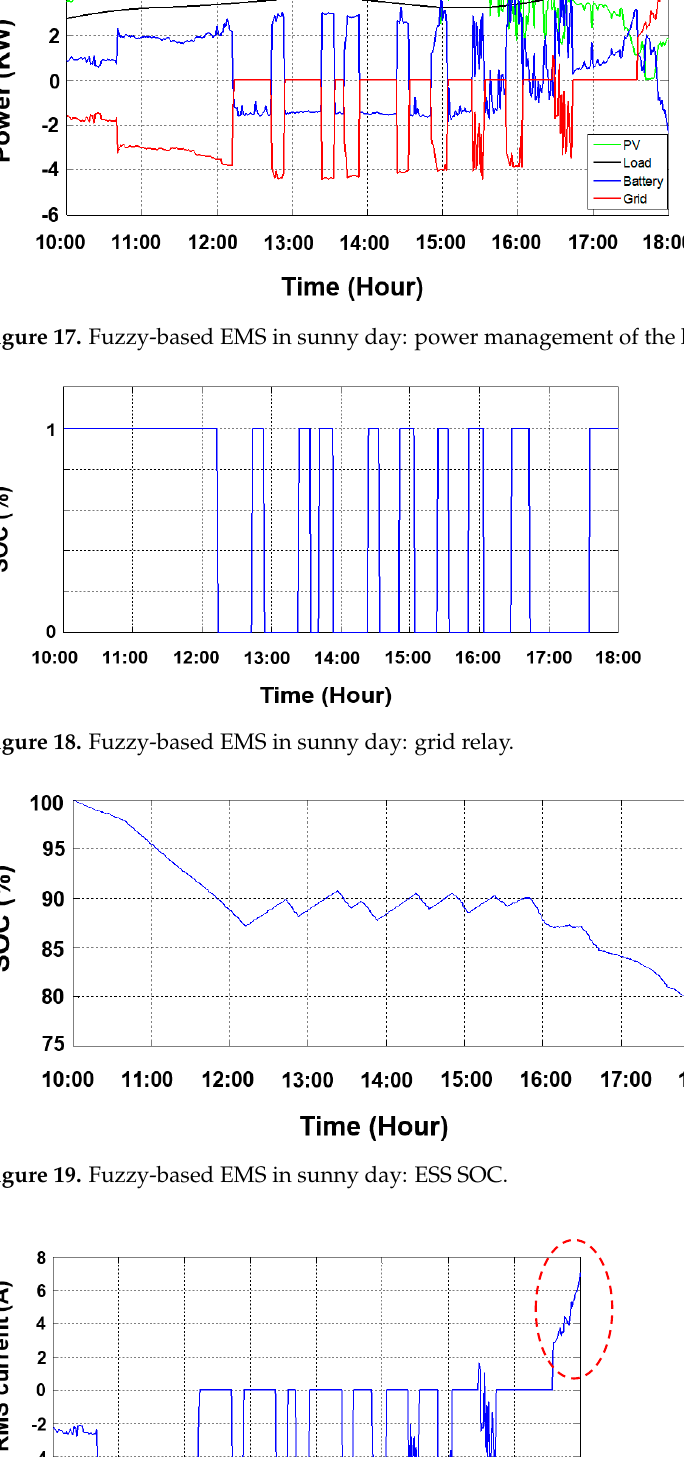
Figure 20. Fuzzy-based EMS in sunny day: grid RMS current.